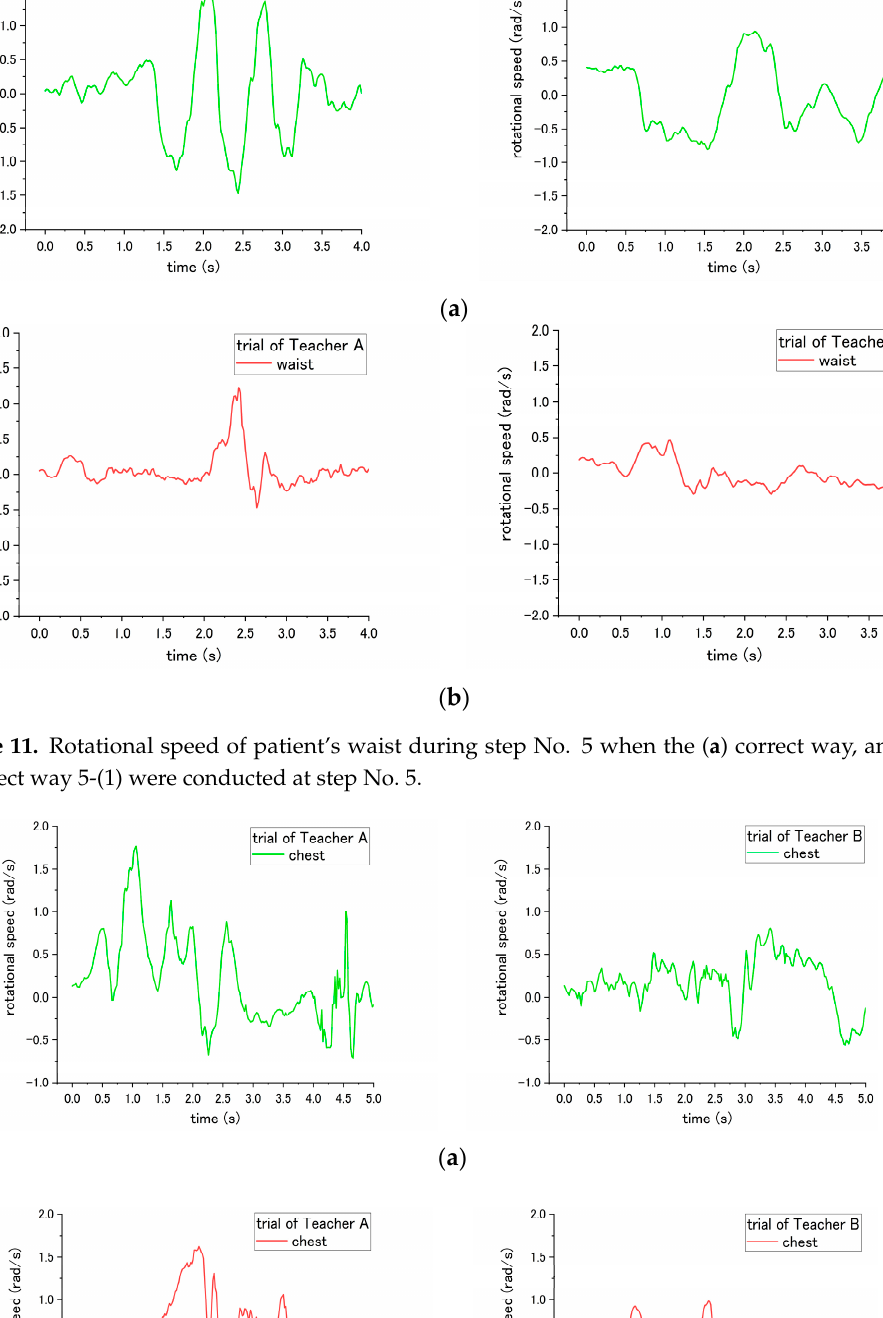
Figure 13. Rotational speed of patient’s chest during step No. 12 when the incorrect way was conducted at step No. 9. 3.5.3. Joint Angle With regard to the joint angle, such movement on a patient enables us to evaluate the correct and incorrect ways of seven steps (No. 2, 5, 6, 7, 11, 15 and 16) in the transfer skill. Step No. 2 is related to the distance from the bed to the wheelchair, settled by the nurse. However, the translational displacement is not measured in this study; therefore, to evaluate the correct and incorrect ways in this step, we probed the joint angle instead. For step No. 2, the appropriate way is to place the wheelchair close to the bed, while the inappropriate is to place the wheelchair too far away from the bed. According to the results, the obvious difference in influence on the patient occurred on the hip joint angle because the patient needs to move farther with more walking paces to reach the wheelchair under the incorrect ways. As shown in Figure 14, a variation between the flexion and extension angle represents the pace of the patient while walking. Moreover, as presented in Table 4,